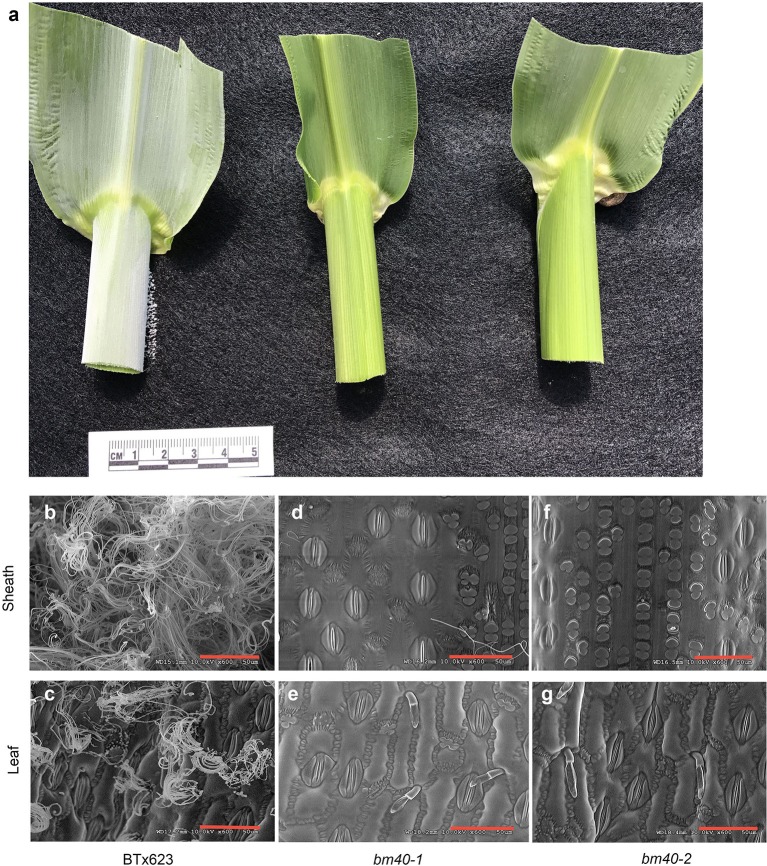
Characterization of the bm phenotype. The second leaf from the top was sampled from BTx623 (left), bm40-1 (middle), and bm40-2 (right) at boot stage when the flag leaf was fully expanded. The top panel shows photographs of leaf and sheath (a). The abaxial leaf surface and sheath of WT BTx623 are covered with EW, whereas in bm40-1 and bm40-2 these organs were almost free of wax. The middle panel shows SEM of sheaths (b,d,f). The bottom panel shows SEM of abaxial surfaces of leaves (c,e,g). Both surfaces were covered with fibrous wax crystals in WT BTx623 but lacked wax crystals in bm40 mutants.